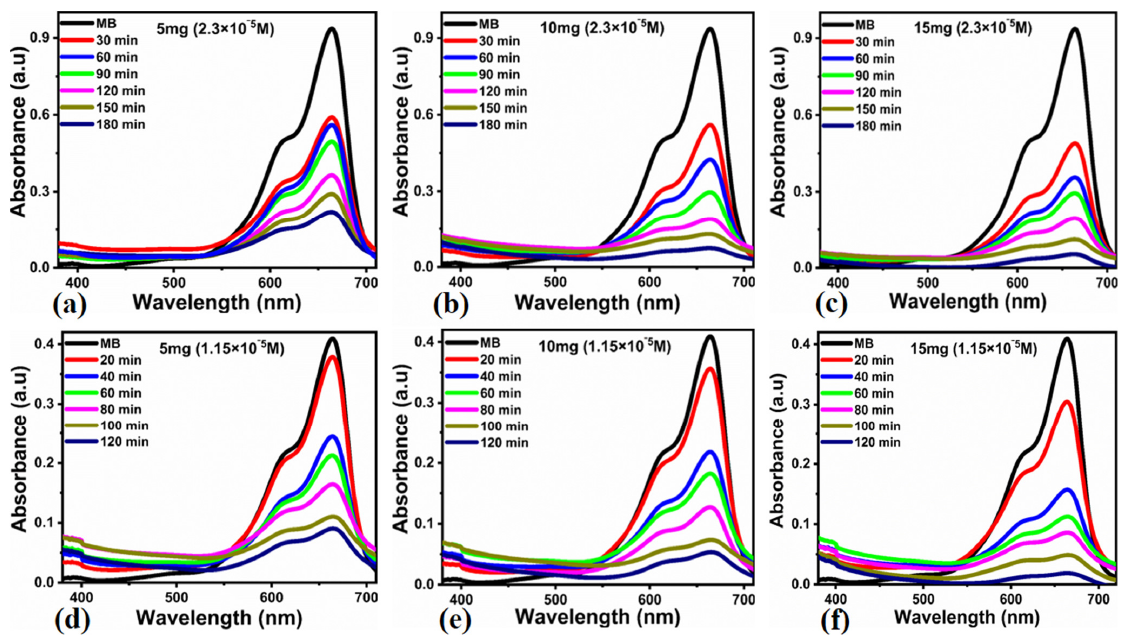
Figure 4. ( a – c ) UV-visible absorbance spectra measured in 2.3 × 10 −5 M MB solution using 5, 10 and